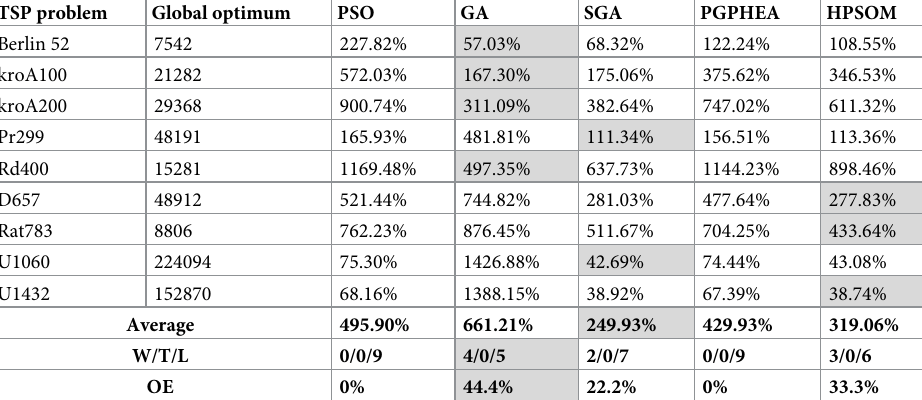
Table 12. Comparison of maximum distance error for traveling salesman